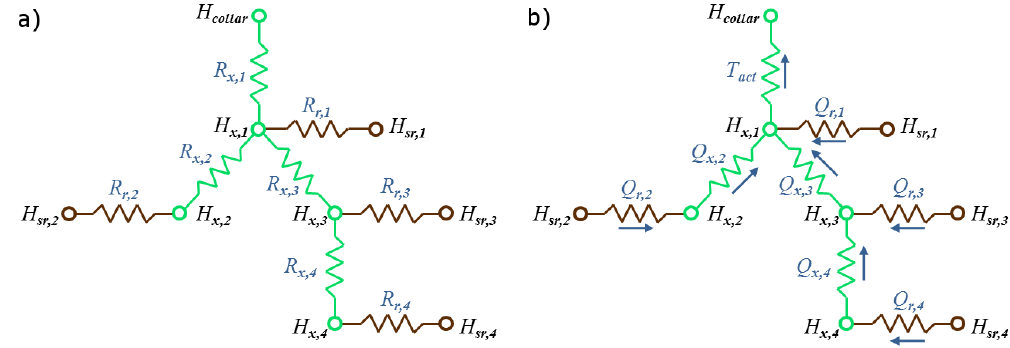
Fig. 1. Scheme of the simple HA and positions of the variables. Soil-root interface water potentials H sr , root xylem nodes water potentials H x and the plant collar water potential H collar are represented at the circles positions. (a) Axial resistances R x between two root xylem nodes and radial resistances R r between a root xylem node and the associated soil-root interface. (b) Root axial water flow rates Q x , root radial water flow rates Q r , the actual transpiration rate T act and their positive directions (arrows).